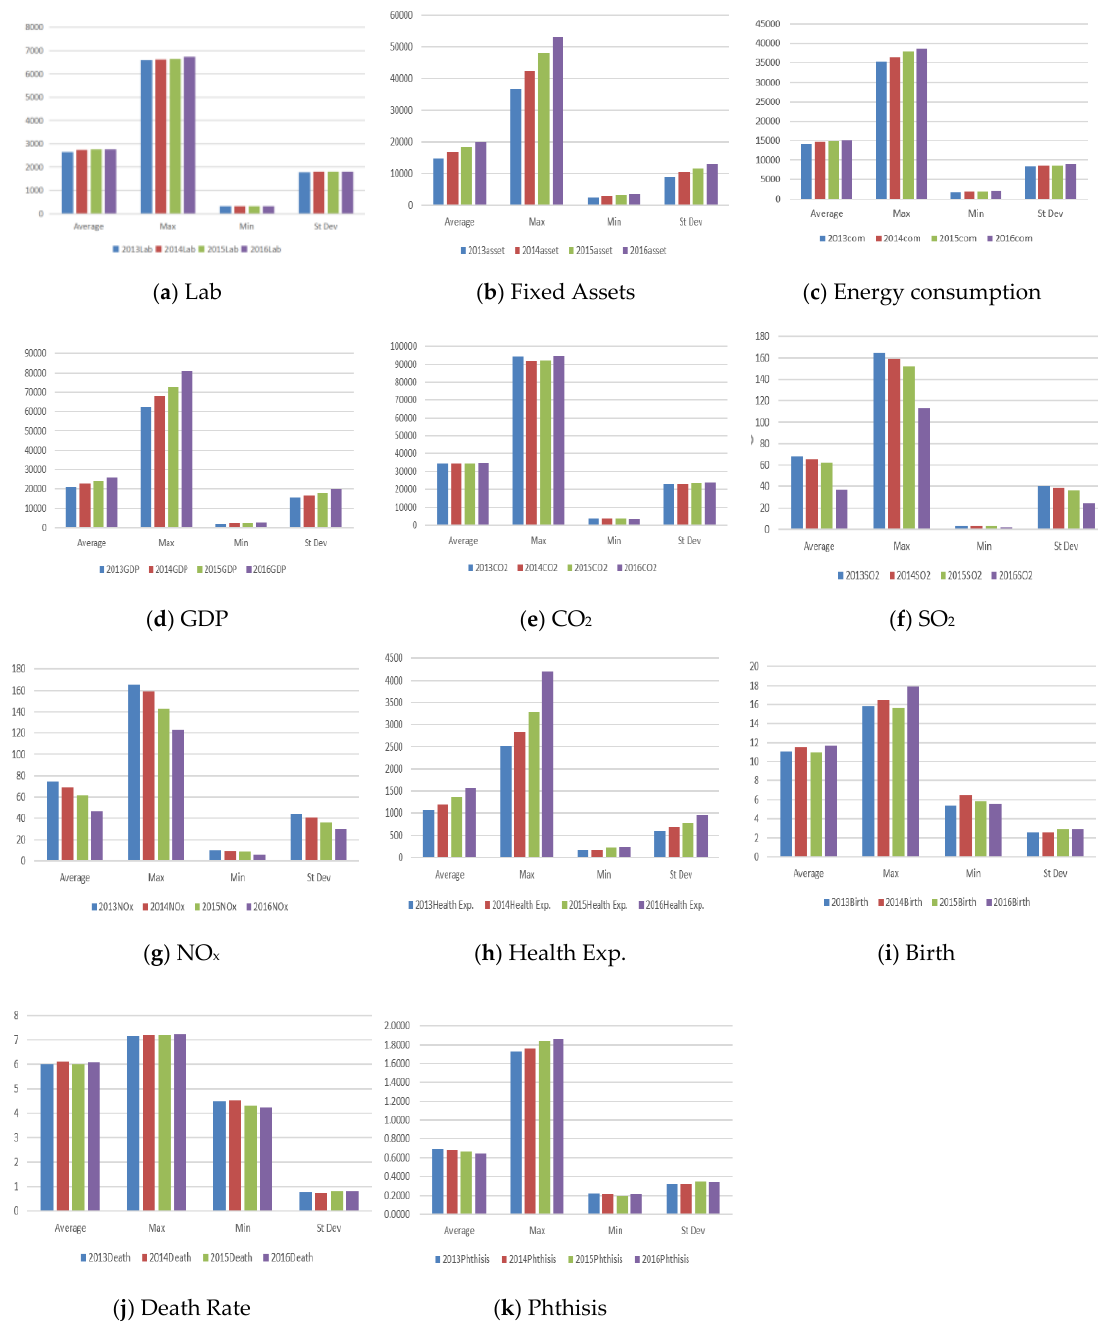
Figure 3. Statistical table of input and output indicators. Inputs include (a) Lab, (c) energy consumption, (h) Health Exp. Outputs include (d) GDP, (i)Birth, (j) Death Rate, (k) Phthisis. Carrey- over is (b) Fixed Assets. Link are (e) CO 2 , (f) SO 2 , (g) NO X